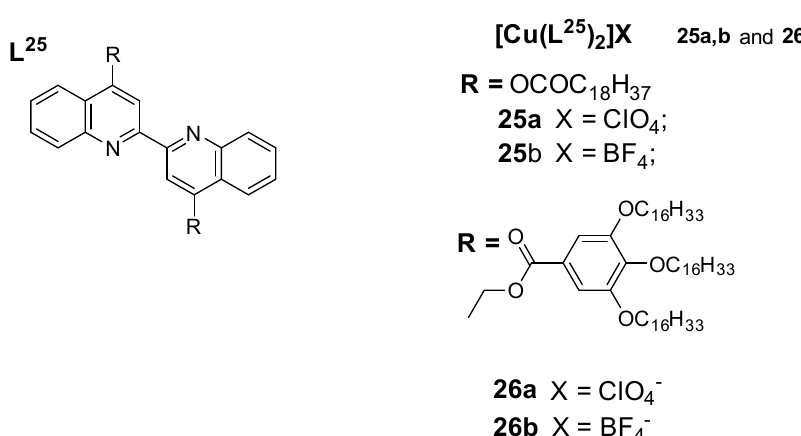
14 Figure 11. Photos of 24 under 365 nm (UV lamp) before and after grinding at 298 and 77 K. Re- printed (adapted) with permission from Chem. Mater. 2016, 28, 22, 8190–8200 (ref. [59]). Copyright 2016 American Chemical Society. Cretu et al. (2018) [60] reported a new class of Cu(I) coordination complexes ( 25a , 25b , 26a , and 26b ) with 4,4’-bisubstituted-2,2’-biquinolines as depicted in Figure 12, which showed low-temperature lamello-columnar and columnar hexagonal thermo- tropic liquid crystalline phases. The highest deduction from the luminescence study is the presence of a medium–low-intensity band with a series of shoulders at 578 nm for 25a and 25b and at 560 nm for 26a and 26b , which is believed to be due to metal-to-ligand charge-transfer (MLCT) electronic transitions. When the solid samples were heated, they